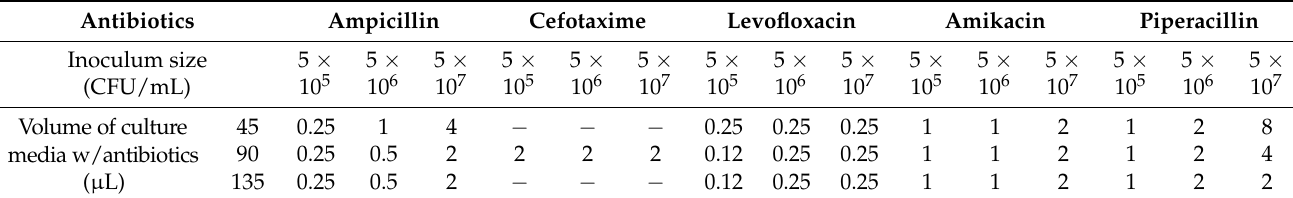
Table 1. Minimal inhibitory concentration (MIC) values of S. aureus according to different bacterial inoculum sizes and volumes of culture media with antibiotics. The unit of MIC is μ g/mL . Antibiotics Ampicillin Cefotaxime Levofloxacin Amikacin